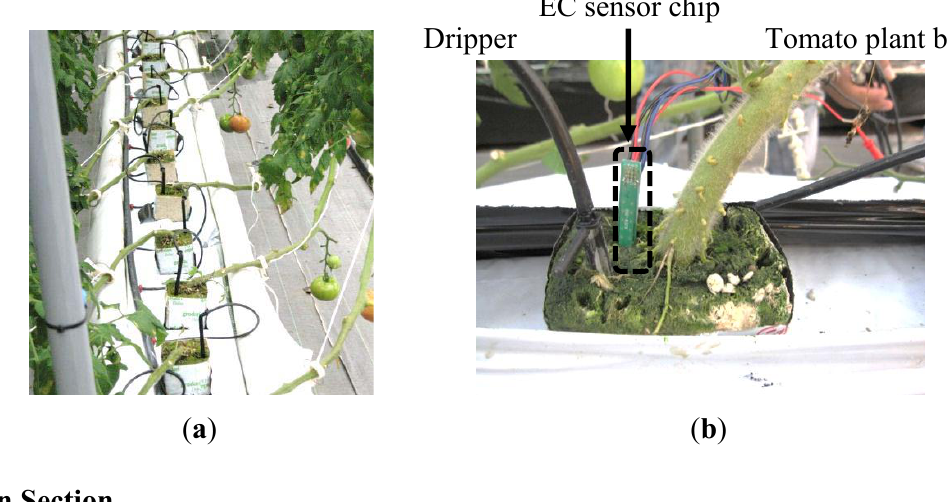
Figure 1. Tomato plants in a soilless rock wool medium for precision agriculture. ( a ) Tomato plants with a dripper in each piece of rock wool; ( b ) An example of in situ EC monitoring in rock wool using a previous EC sensor. The sensor size could be inserted without